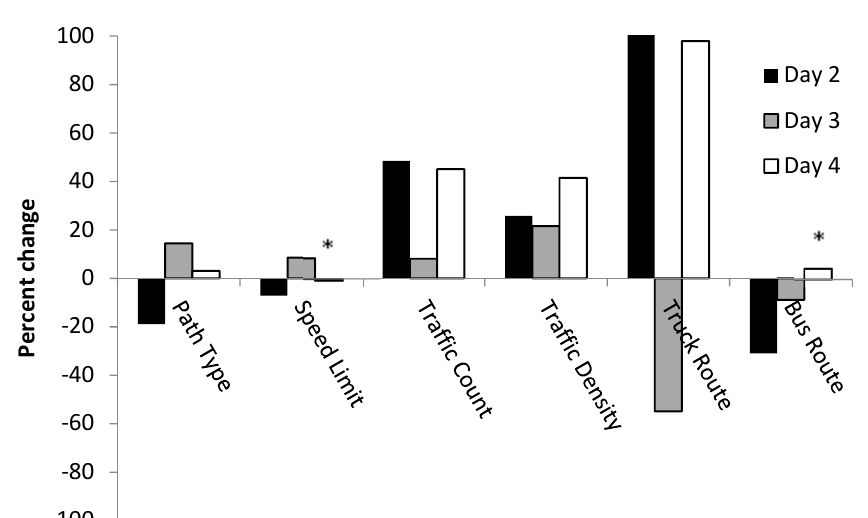
Figure 9. Percent change in traffic-related predictor variables between the 20% most heavily polluted segments of the cycled network and the remainder of the cycled path. * denotes an insignificant difference (two-tailed t -test, equal variances not assumed p > 0.05).